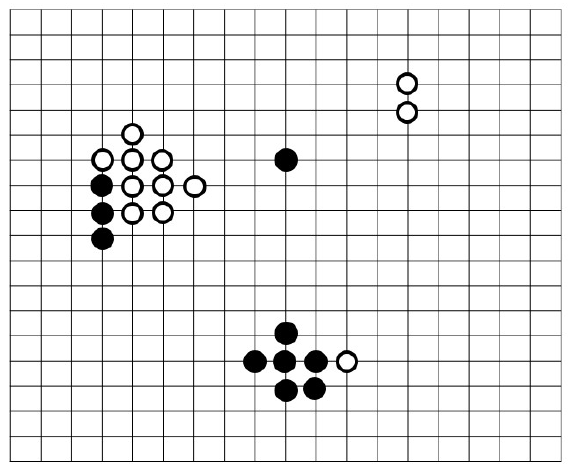
Figure 3: An illustrative configuration of the Go game after several moves